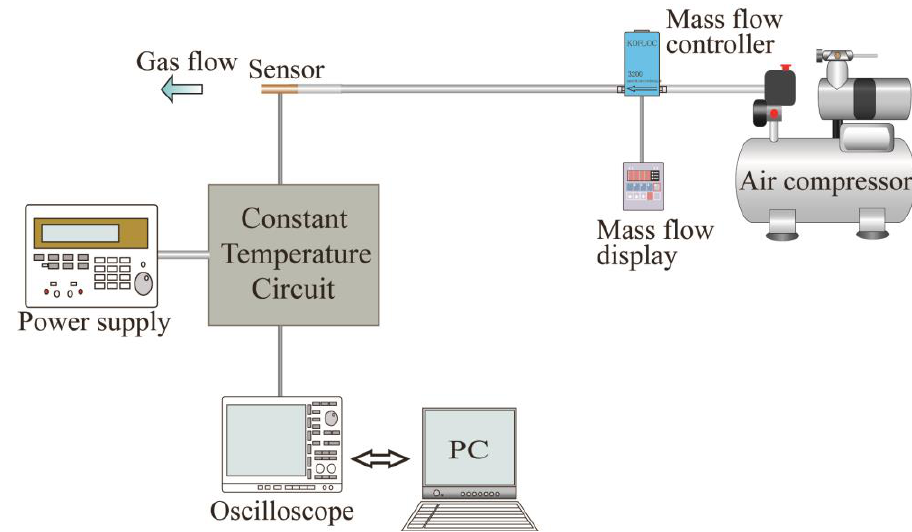
Figure 9. Experimental setup for characterization of the fabricated sensor.